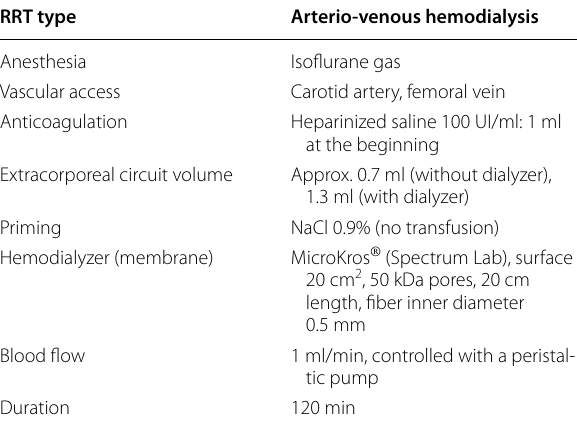
Table 1 Hemodialysis model in rats: